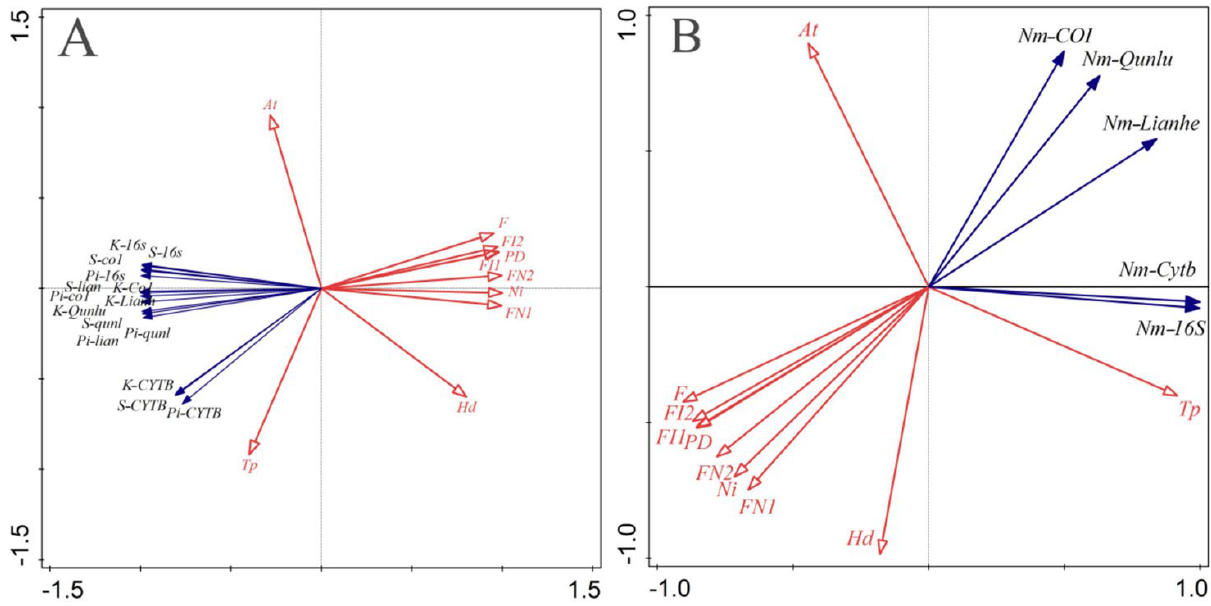
Figure 10. Redundancy analysis of genetic diversity and geographical environment factors of Ery- throneurine leafhoppers (( A ): Genetic diversity parameters; ( B ): Gene−flow ).